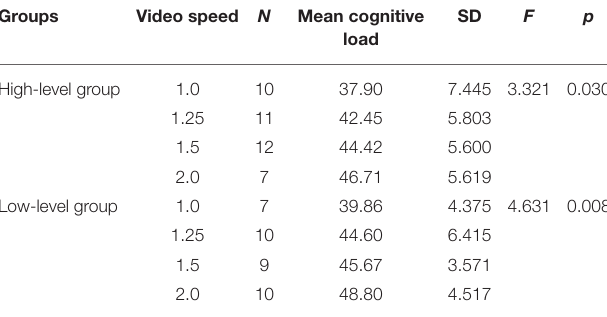
TABLE 6 | Influence of video speed and learning ability on cognitive load shown by covariance analysis.